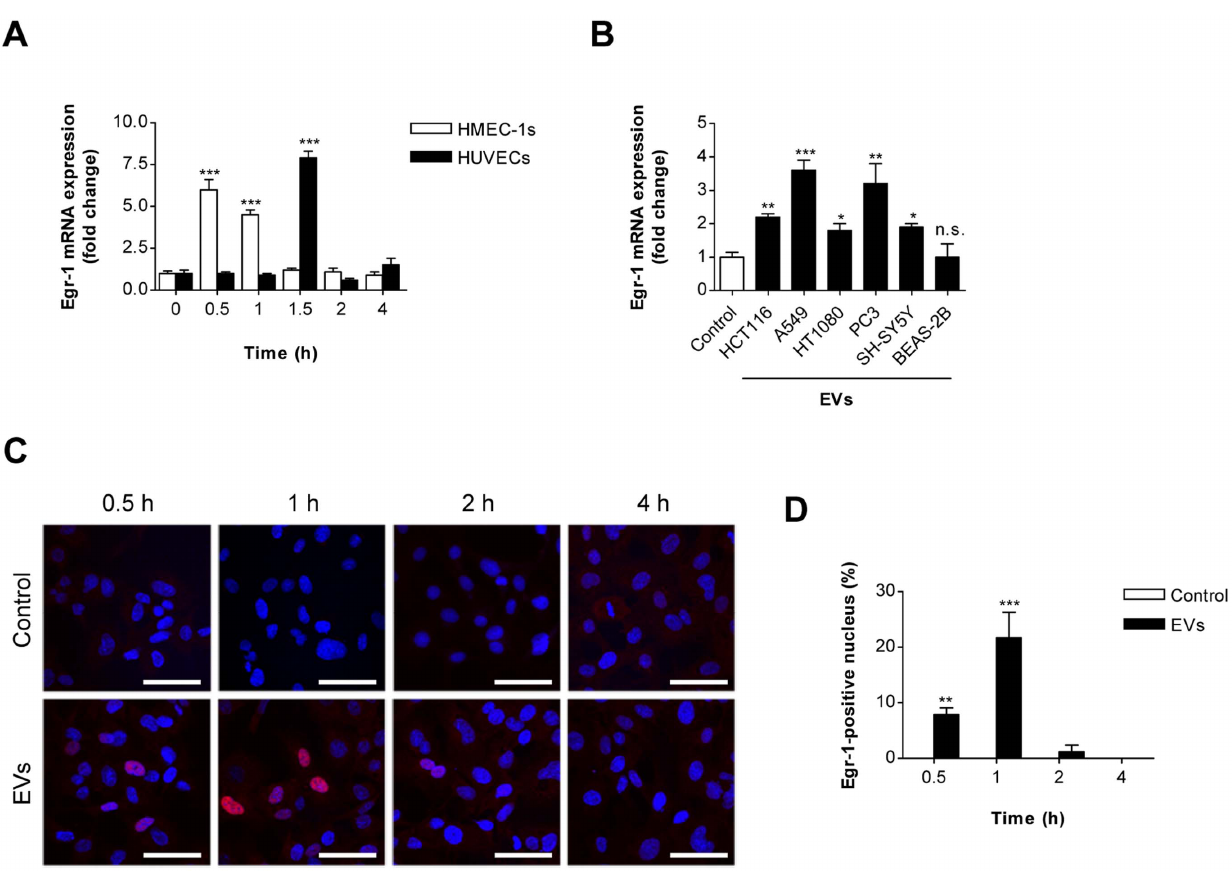
Fig. 2. Egr-1 activation in endothelial cells by SW480-derived EVs. (A) HMEC-1s and HUVECs were incubated with SW480-derived EVs (1 m g/mL) or untreated control. mRNA was isolated from untreated control cells or cells treated with EVs for 0, 0.5, 1, 2, and 4 h and analyzed using real time RT-PCR (n 5 3). Values represent Egr-1 mRNA/GAPDH mRNA normalized to untreated control cells. (B) HMEC-1s were treated with EVs (1 m g/mL) derived from HCT116 colorectal carcinoma, A549 lung adenocarcinoma, HT1080 fibrosarcoma, PC3 prostate carcinoma, SH-SY5Y neuroblastoma, and BEAS-2B normal bronchial epithelial cells for 0.5 h (n 5 3). (C, D) In HMEC-1s, nuclear translocation of Egr-1 protein after stimulation with SW480-derived EVs (1 m g/ mL) for 0.5, 1, 2, and 4 h was analyzed under confocal microscopy (n 5 3). Nuclei and Egr-1 proteins were stained with Hoechst (blue) and anti-Egr-1 antibody (red), respectively. Co-localized fluorescence signals (purple) indicate the translocation of Egr-1 into the nucleus. Representative photographs are shown in panel C. Scale bars represent 30 m m. The percentage of Egr-1-positive nuclei was determined by measuring the number of cells with nucleus colocalized signals over that of total cells (D). Data are represented as mean ¡ SD. * P , 0.05; ** P , 0.01; ** P , 0.001; n.s., not